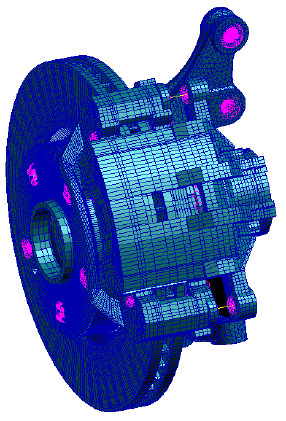
Figure 1. FE model of the assembled brake system.